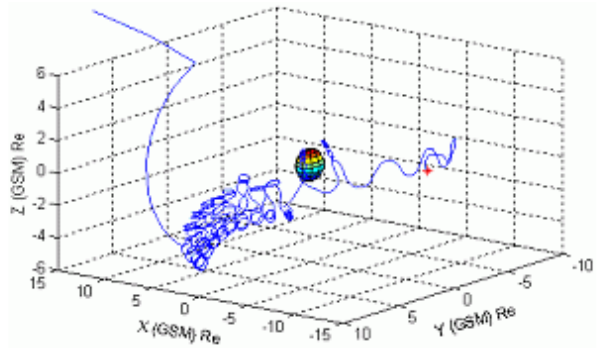
Fig. 8. A chaotic injection trajectory of an 20keV O + with equa- torial pitch angle of 60 ◦ initially located at x =− 8 R E , y =− 2 R E , and z = 0 in T96 with D st =− 100nT magnetic field model and HMR electric